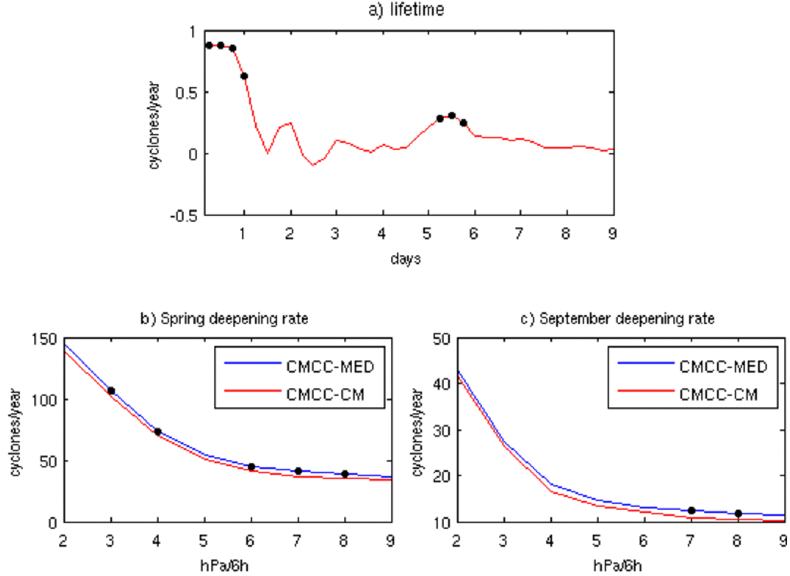
Fig. 3. Cyclone statistics. Panel (a) : lifetime difference between CMCC-MED and CMCC-CM. Panel (b) : maximum deepening rate (hPa/6h) in both models for the spring season. Panel (c) : as panel (b) , but for September. Black dots mark statistically significant